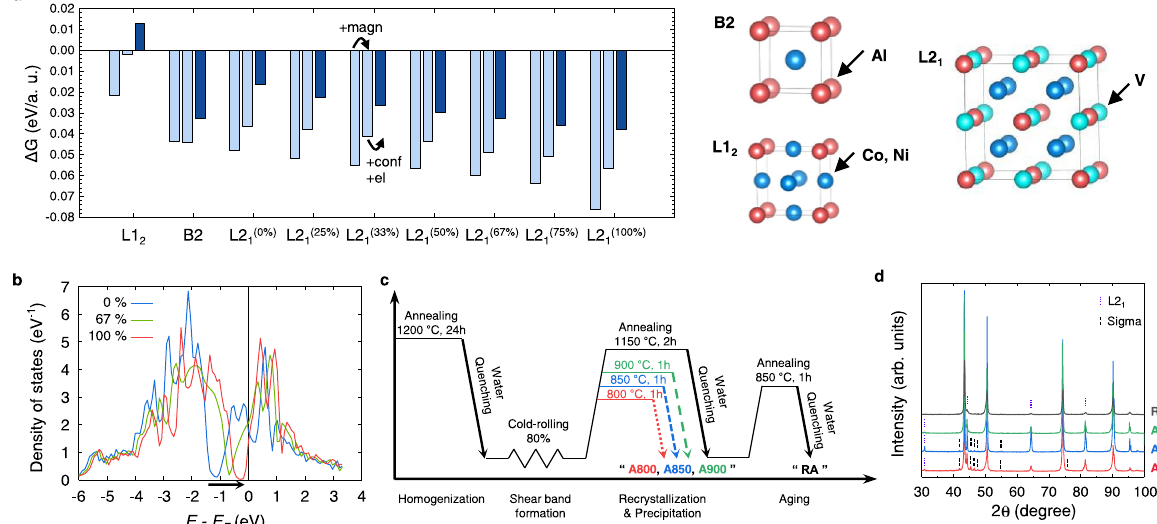
Fig. 1 Material and process design. a Free energy of the candidate precipitates with respect to the solid solution. The percentages for the L2 1 phase indicate the occupation of the (Co,Ni) sublattice by Co. For each phase, the fi rst, second, and third bars represent the 0 K ( − 273 °C) energy difference in the ferromagnetic state, the 0 K ( − 273 °C) energy difference in the paramagnetic state, and the free energy difference at 1150 K (877 °C) with the inclusion of con fi gurational and electronic entropy, respectively. b Densities of states of the L2 1 phase for different Co contents in the ferromagnetic state. c Schematics of the thermomechanical processing for precipitation-strengthened Al 0.2 CoNiV alloys. d Phase identi fi cation via X-ray diffraction (XRD) analysis of the annealed Al 0.2 CoNiV